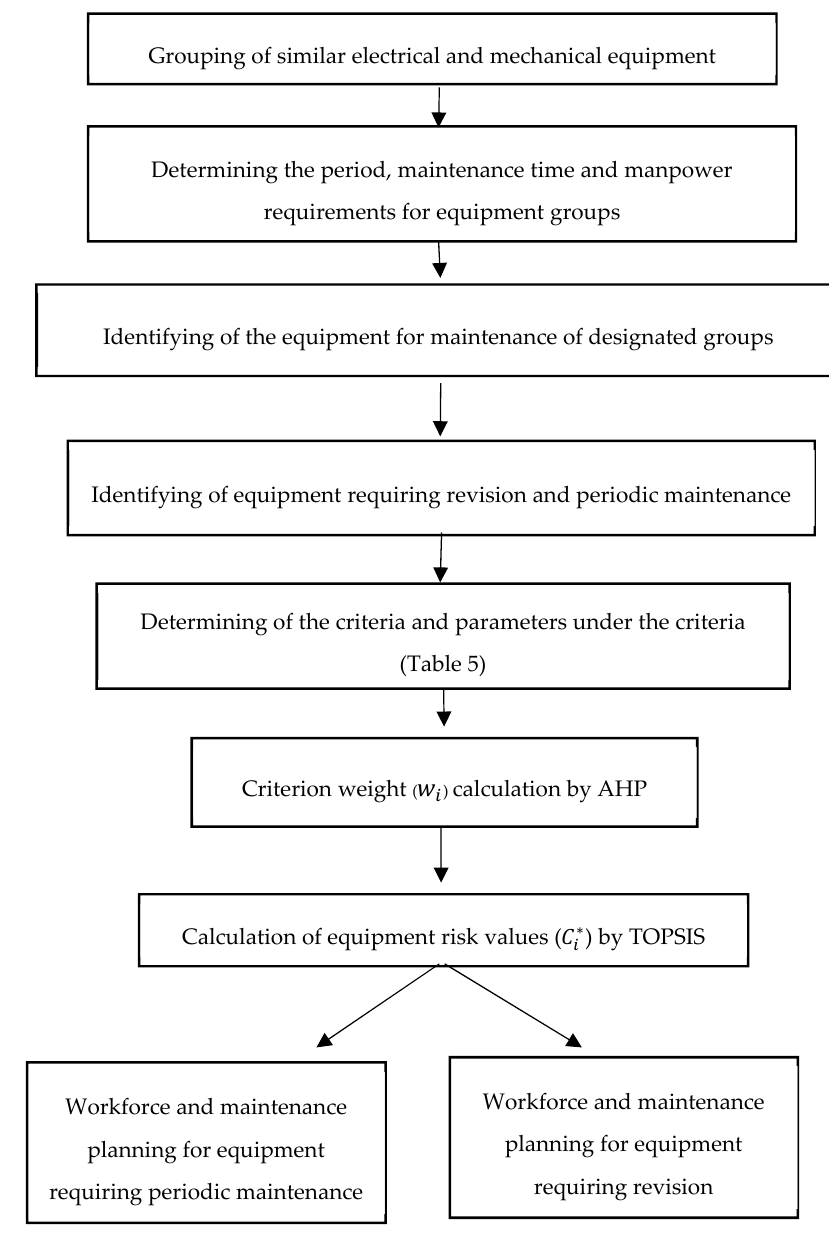
Figure 2. Application steps. Table 3. Data of electrical equipment groups.